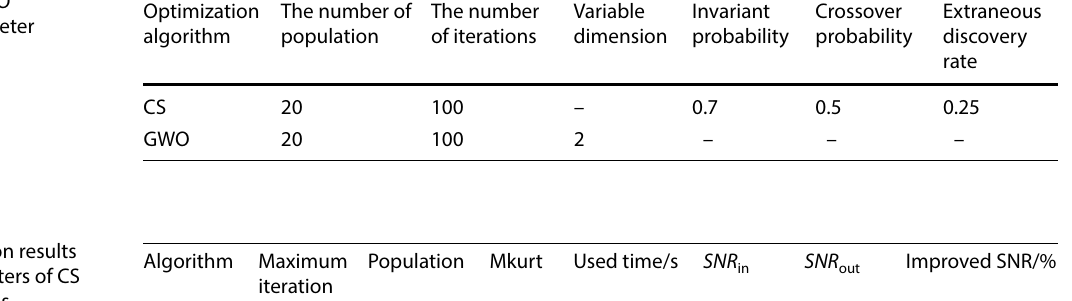
Table 3 Optimization results and related parameters of CS and GWO algorithms